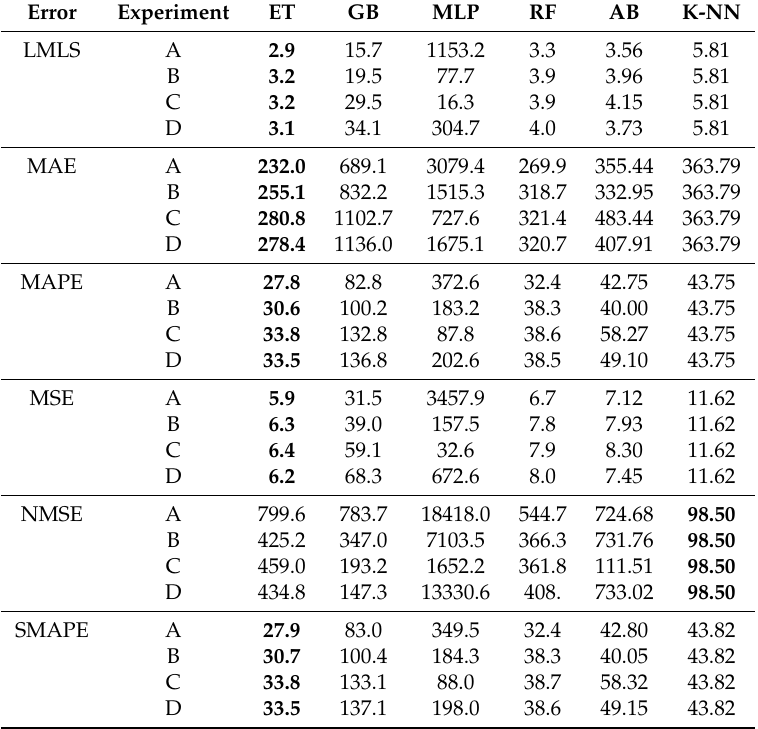
Table 2. Day model errors (multiplied by 10 5 ) for extremely randomized trees(ET), gradient boosting (GB), multi-layer perceptron (MLP), random forest (RF), adaptive boosting (AB), and k-nearest neighbors